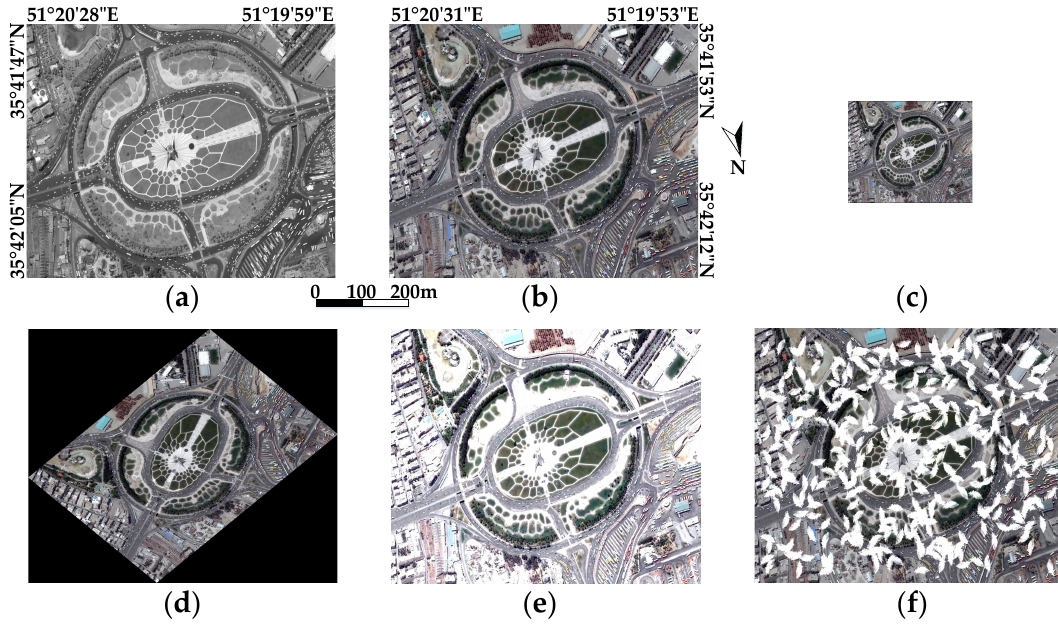
Figure 7. Examples of synthetic images. ( a ) Panchromatic satellite image from WorldView-1; ( b ) the corresponding RGB image of ( a ) from QuickBird; ( c ) synthetic image with a scale ratio of 0.4; ( d ) synthetic image with a rotation angle of 45 ◦ ; ( e ) synthetic image with considerably higher brightness than the original image; ( f ) synthetic image with mass cloud patches.